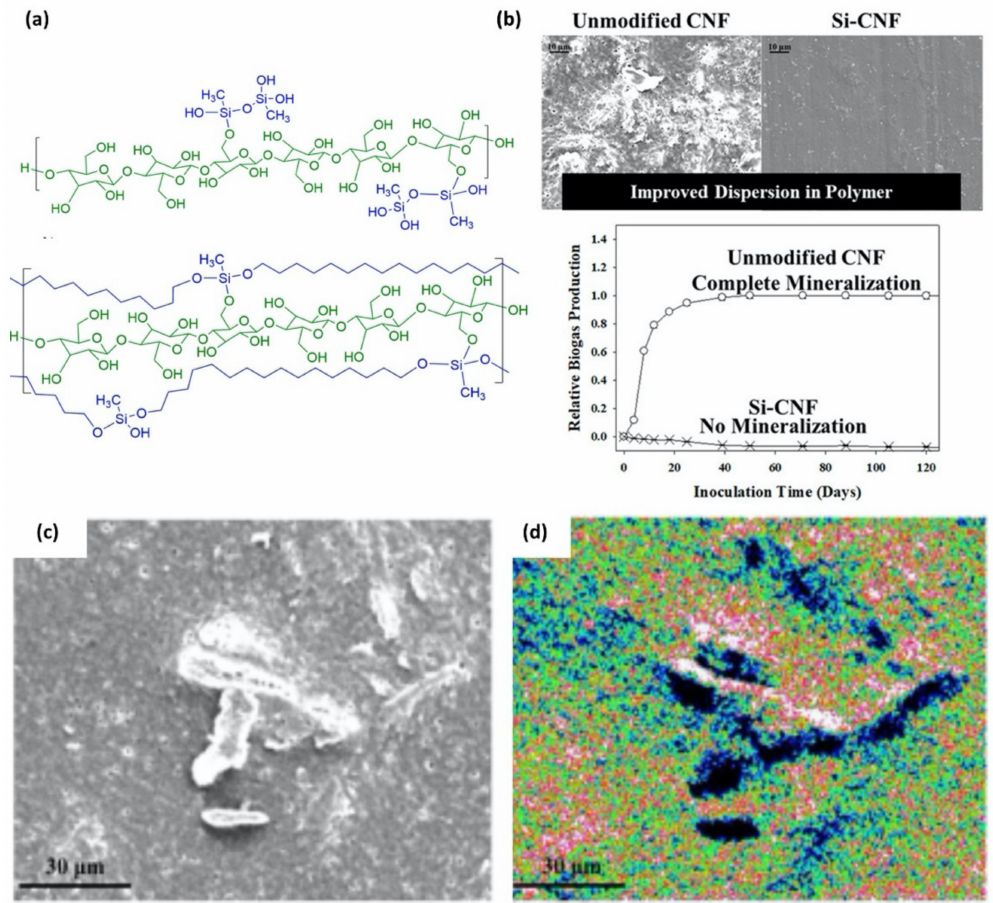
Figure 13. ( a ) Chemical structures of cellulose nanofibrils (CNFs) with the siloxane coating (blue) on the CNF (green) through covalent bond. ( b ) SEM image of the nanocomposite surface (top) and biogas production capability (bottom) for unmodified CNFs and siloxane coated CNFs. ( c ) SEM image and ( d ) energy-dispersive X-ray spectroscopy (EDS) oxygen mapping of an aggregation of unmodified CNFs in polyhydroxyalkanoates (white color representing high oxygen concentration). (Reproduced with permission from Reference [97]; Copyright (2018) American Chemical